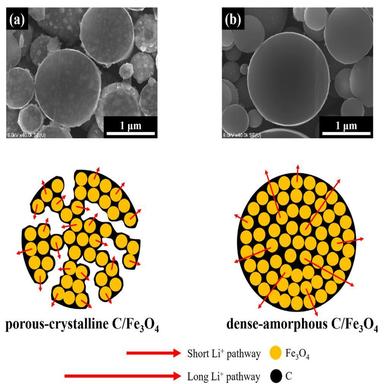
Cross-sectional FE-SEM images and Li-ion diffusion schematics of the porous-crystalline (a) and dense-amorphous (b) C/Fe3O4 microspheres.